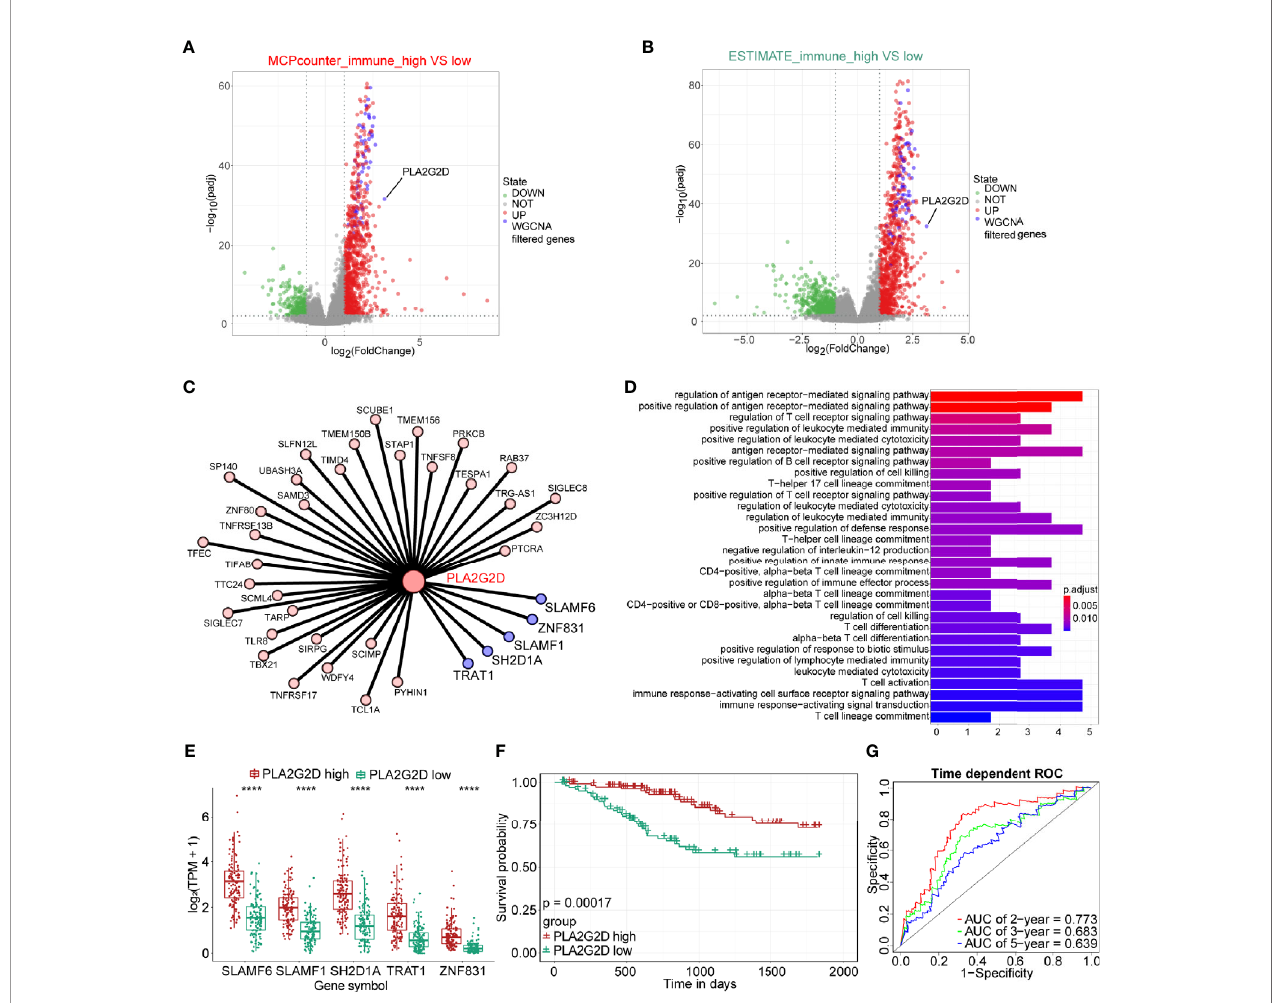
FIGURE 4 | The expression of PLA2G2D is positively correlated with immune in fi ltration and patient survival. Volcano plot for DEGs identi fi ed for high- and low- immune in fi ltration groups based on the MCP-counter (A) and ESTIMATE (B) . The green and red dots represented the signi fi cantly downregulated and upregulated genes, respectively, and the gray dots represented the undifferentiated genes; the purple dots showed the WGCNA fi ltered genes, with |Log 2 (FoldChange)| >1 and adjusted P -value <0.01. (C) Cytoscape network plot showed the relationship between PLA2G2D and other co-expressed genes with weight value >0.2. The purple nodes showing the co-expressed genes with weight value >0.3. (D) GO pathways enrichment analysis for genes co-expressed with PLA2G2D . (E) Histogram showing the relationship between the expression levels of PLA2G2D and other fi ve co-expressed genes, **** P < 0.0001. (F) Kaplan – Meier survival curve plot showing the relationship between PLA2G2D expression level and patient survival. (G) Time-dependent ROC curve analysis for minus PLA2G2D TPM value at 2-, 3-, and 5-year